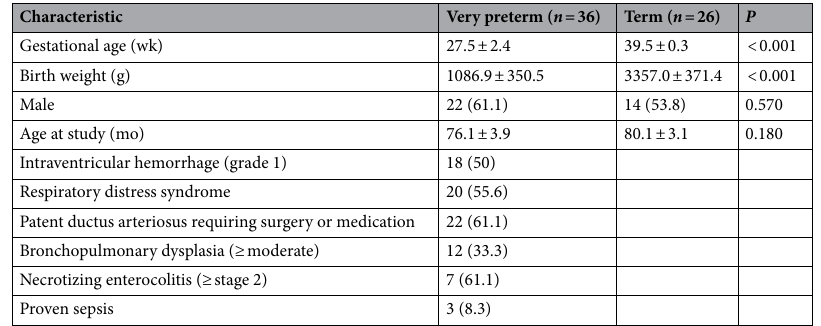
Table 1. Demographic and clinical characteristics. Data are presented as mean ± standard deviation for continuous variables and n (%) values for categorical